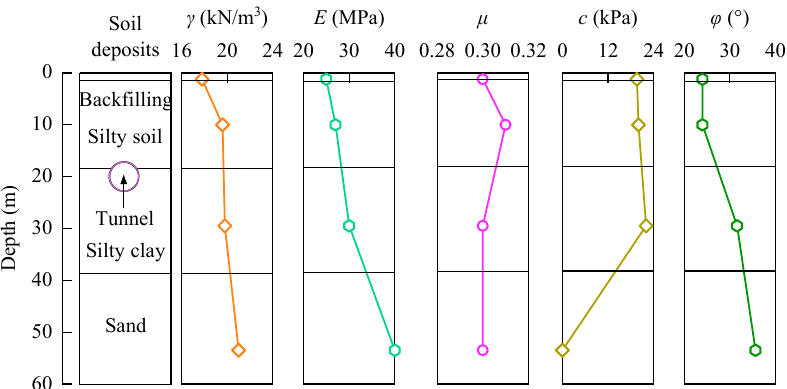
Figure 2. Soil properties profile of worksite [33].